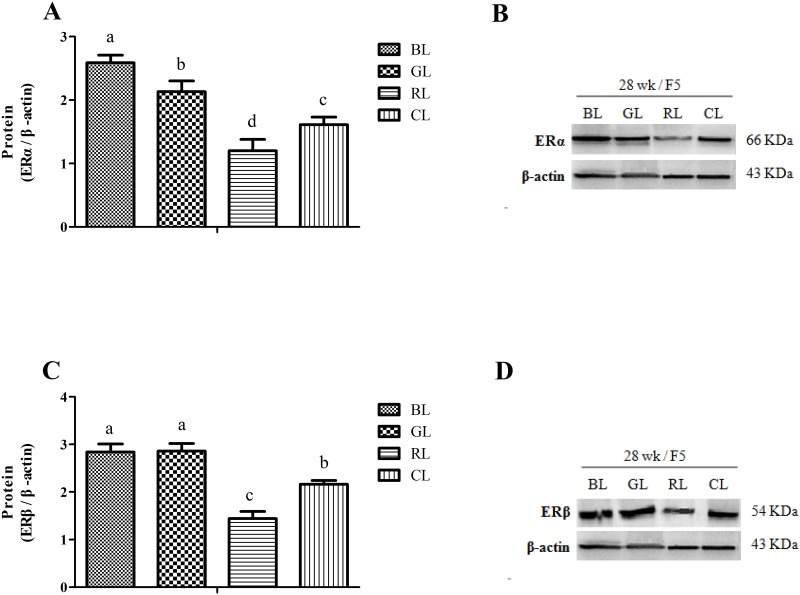
Effects of monochromatic light on ER isoform protein content in F5 of laying hens at 28 wk.(A) Protein abundance of ERα and (C) ERβ. Proteins detected by western blot from the chicken F5 were quantified by densitometric analysis and normalized to β-actin protein content. (B) Representative blots of ERα and β-actin, and (D) ERβ and β-actin. Results are expressed as mean ± SD (n = 5). BL = blue light, GL = green light, RL = red light, and CL = cool white light (control group). ERα = estrogen receptor-α, ERβ = estrogen receptor-β. Least squares means with different letters are significantly different (P < 0.05).